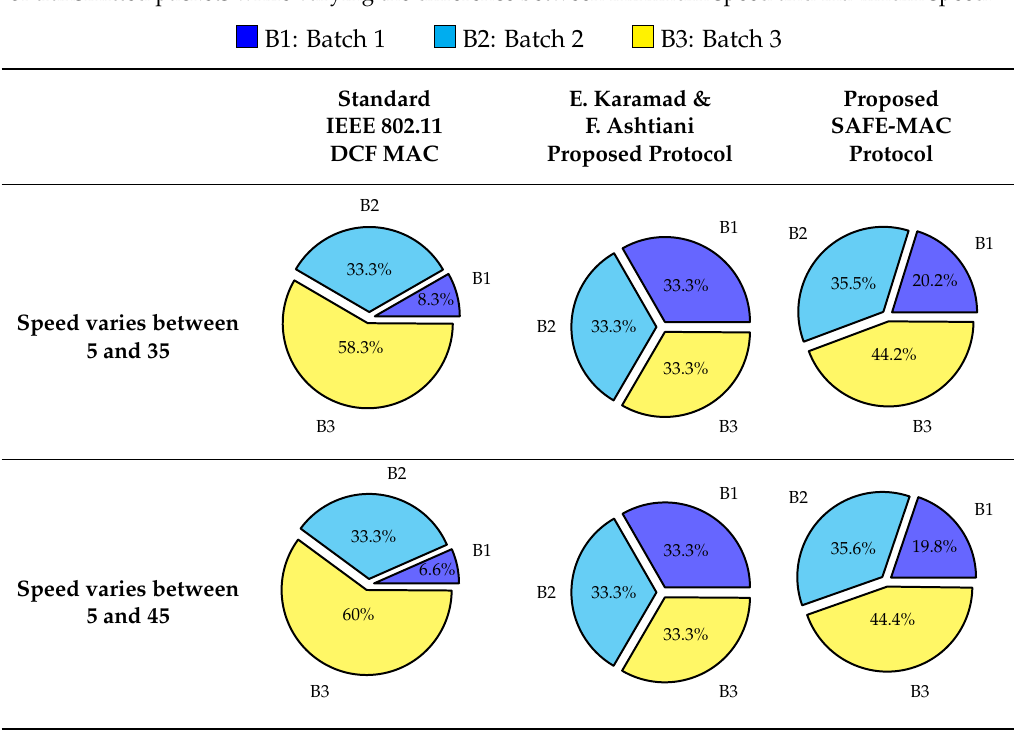
Table 6. Performance comparison of SAFE-MAC with contemporary protocols in terms of percentage of transmitted packets while varying the difference between minimum speed and maximum